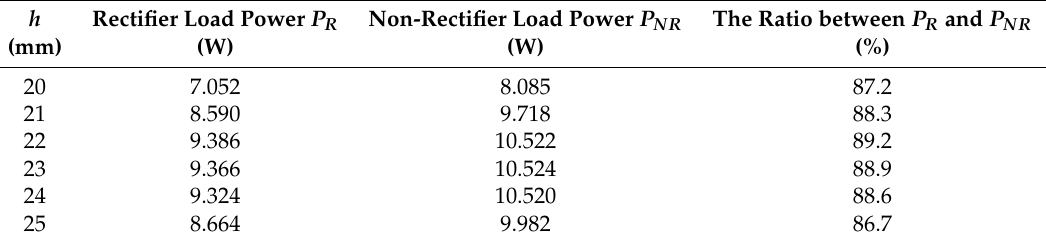
Table 3. Load power of the system when using bridge rectifier circuit or not using